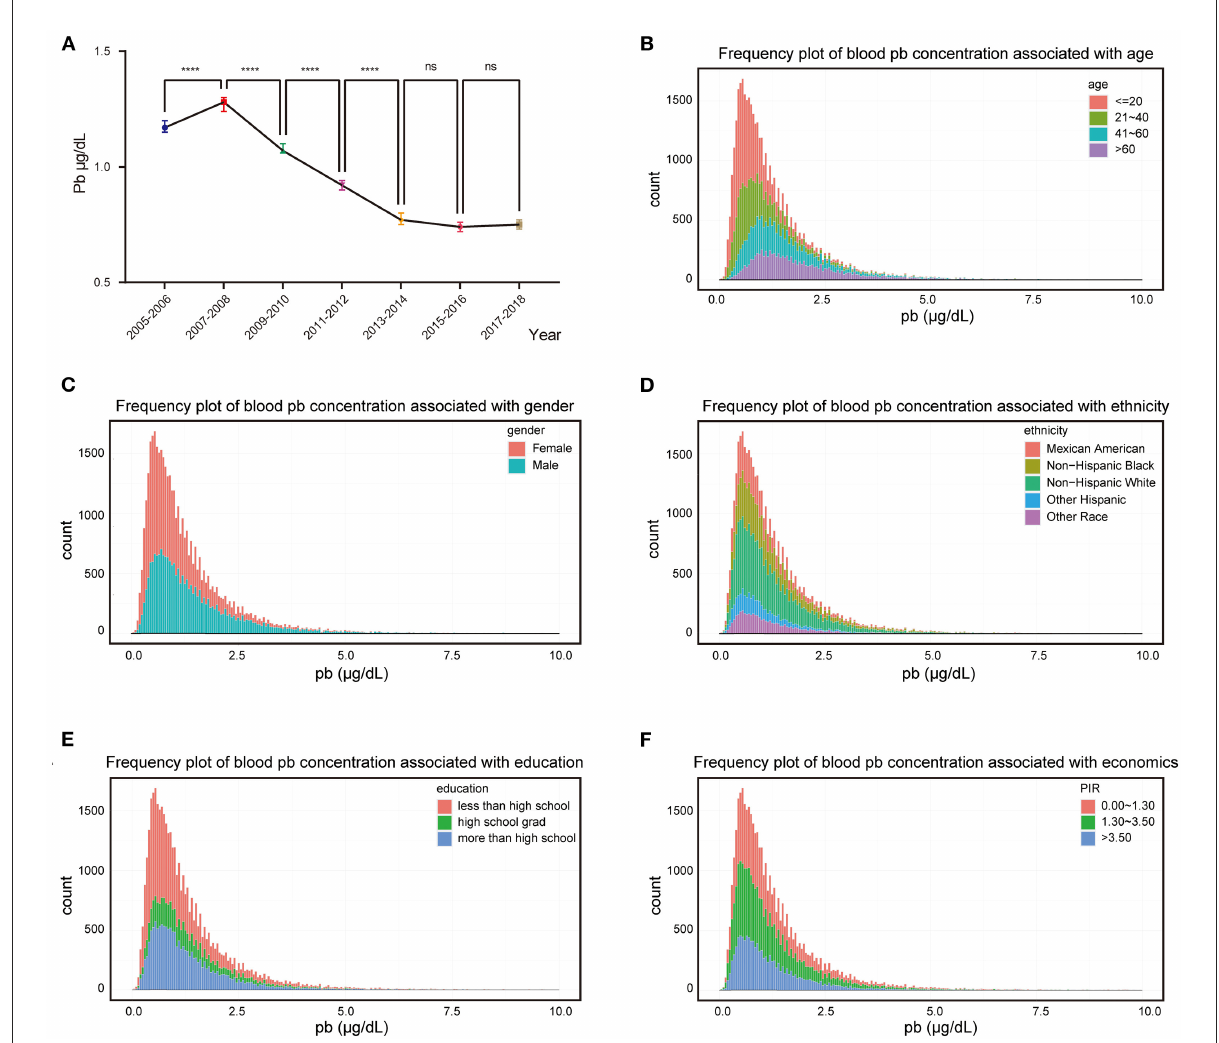
FIGURE1 Exposure patterns in the US. (A) Median blood lead concentration in the population for each survey cycle, bars represent 95% confidence interval; (B–F) Frequency distributions of blood lead concentrations were plotted and merged with demographic characteristics. **** p -value < 0.0001; ns, no